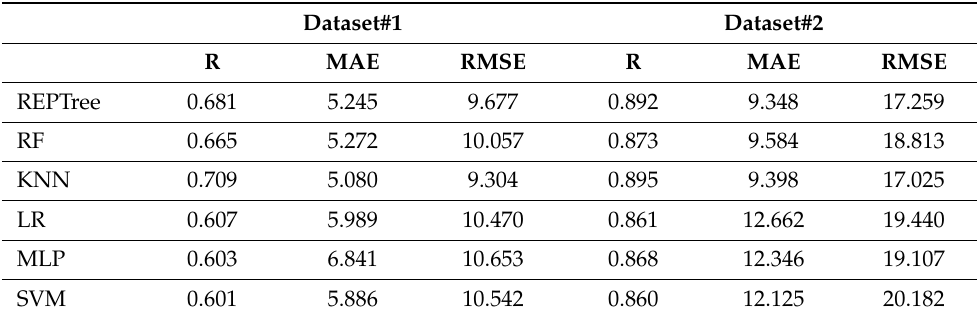
Table 2. Regression analysis results for the LCOM2 metric after outliers and extreme values were removed.